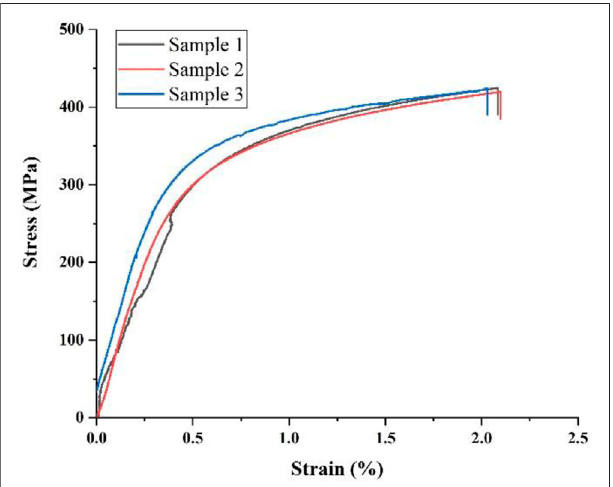
FIGURE 3 | Stress-strain curves of